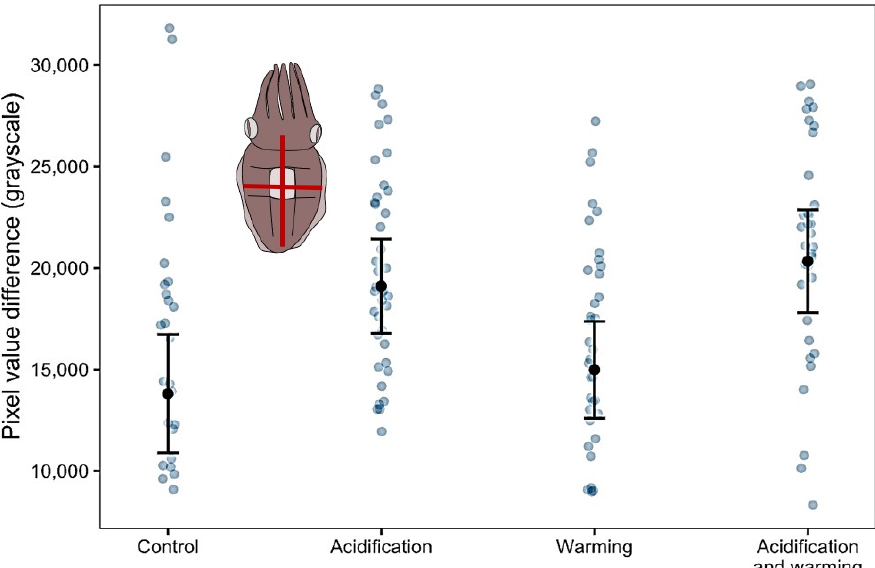
Figure 3. Pixel values range (difference between the maximum and minimum pixel intensity; grayscale units) along the frontal and transversal body planes of cuttlefish exposed to treatments: control, acidification, warming, and acidification and warming combined. Points represent predicted means, and bars represent confidence intervals from a linear model. Blue points represent observed individual data.